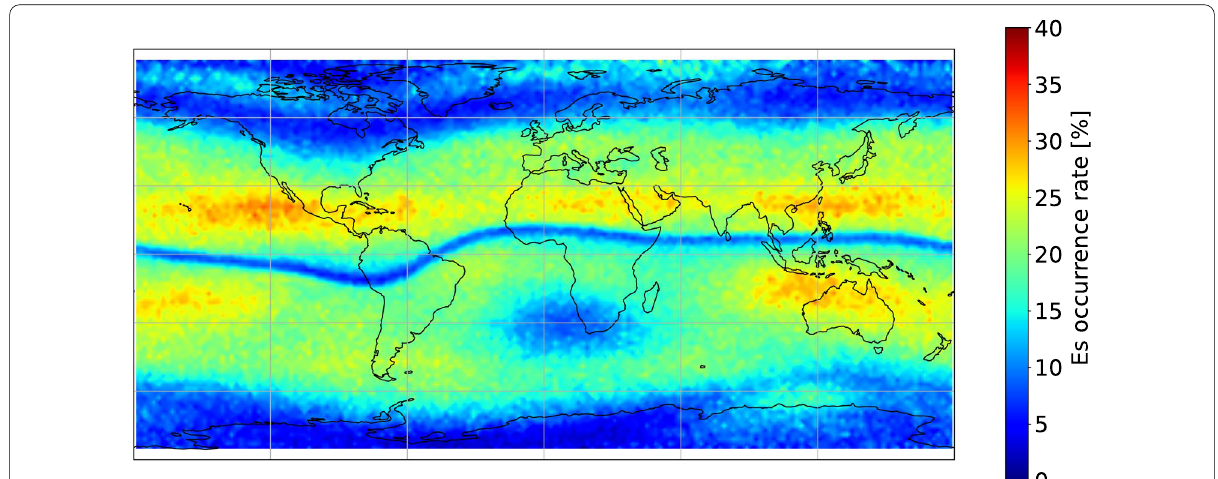
Fig. 4 Map of global sporadic E occurrence rate in a 2 ◦ x 2 ◦ resolution. This plot is a composite of RO data collected by several satellite missions between 2007 and